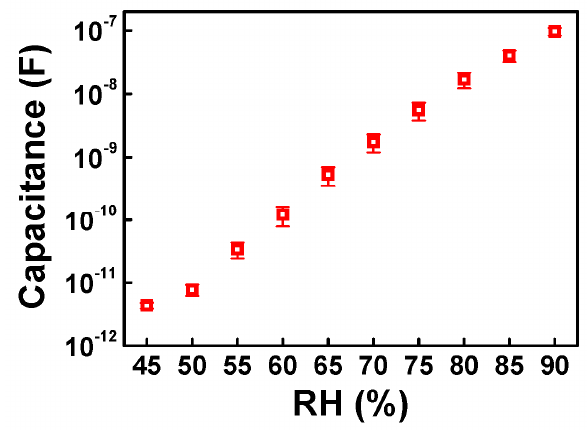
Figure 3. Average and standard error of sensing characteristics of four H-PTFE flexible humidity sensors.